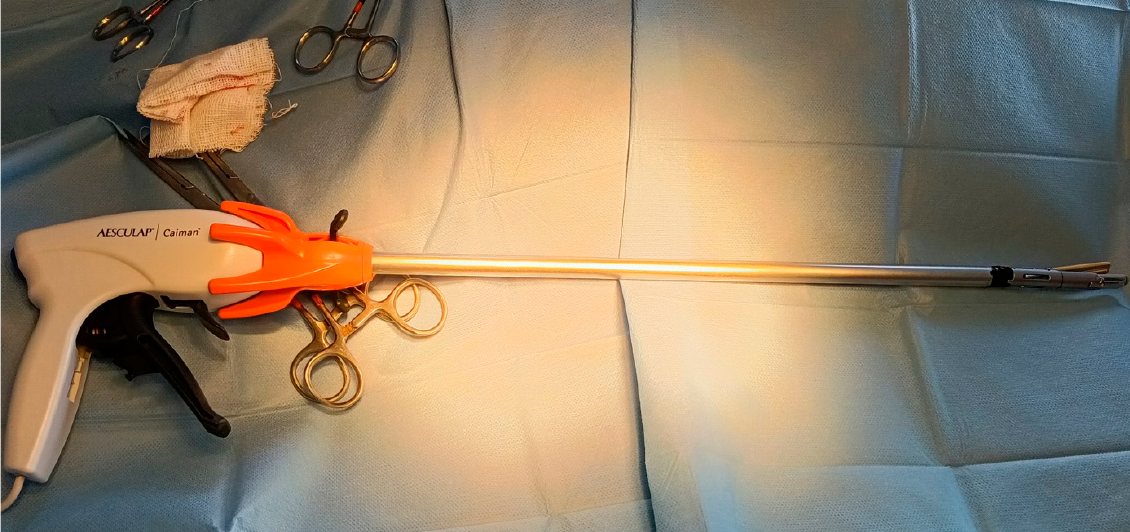
Figure 1. Image of the Caiman 12. The handpiece has a 12-mm wide diameter, with 50-mm long branches. The tip of the instrument is articulated.